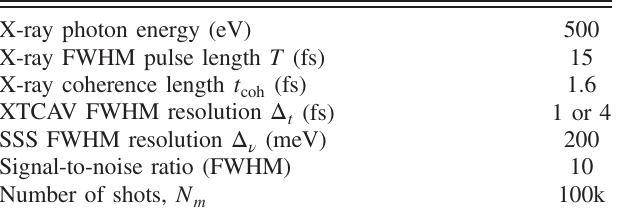
TABLE I. Parameters for simulations based on LCLS soft x-ray operation. The signal-to-noise ratio is relative to half-max of the signal and is added to M , A , and A ð f Þ .